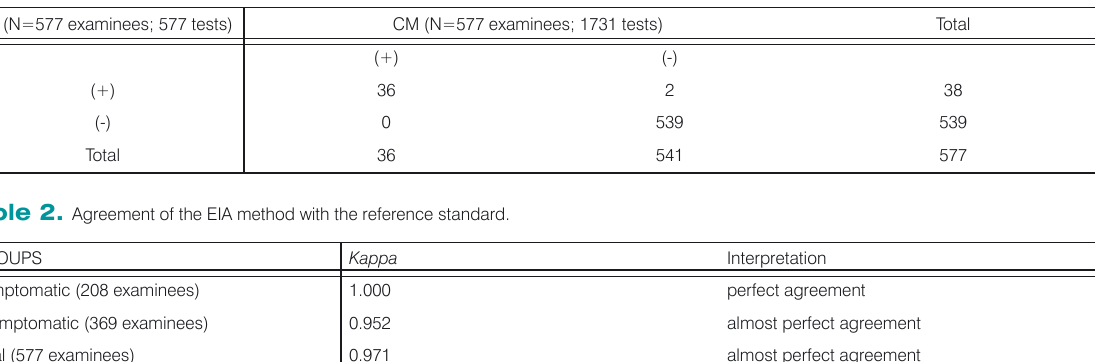
Table 1. Comparison of the CM plus CCT and EIA results.